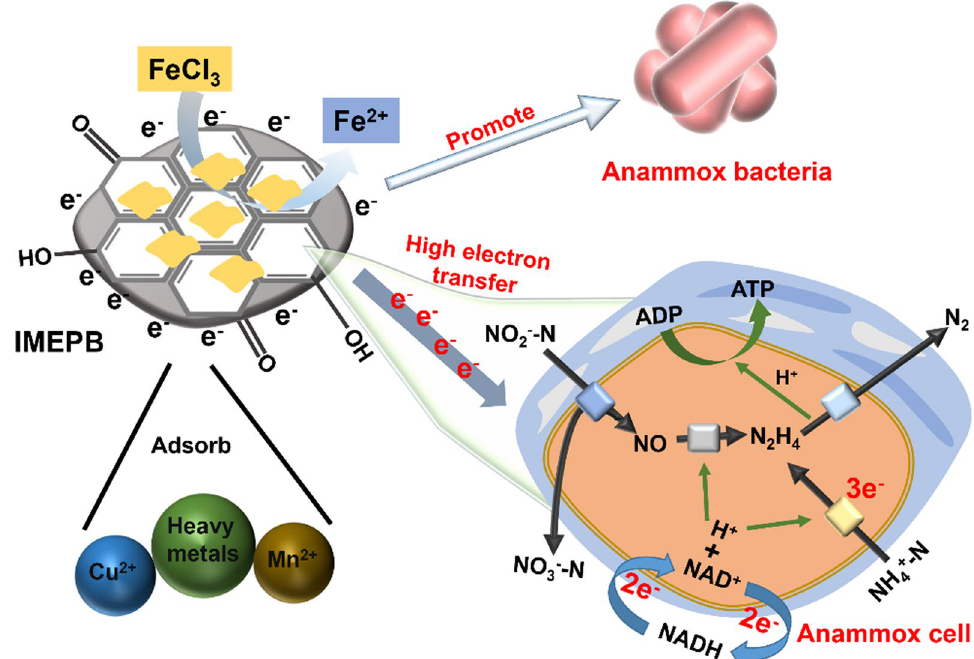
Fig. 7 The schematic of the possible mechanism of iron-modified Enteromorpha prolifera biochar reinforcing anammox